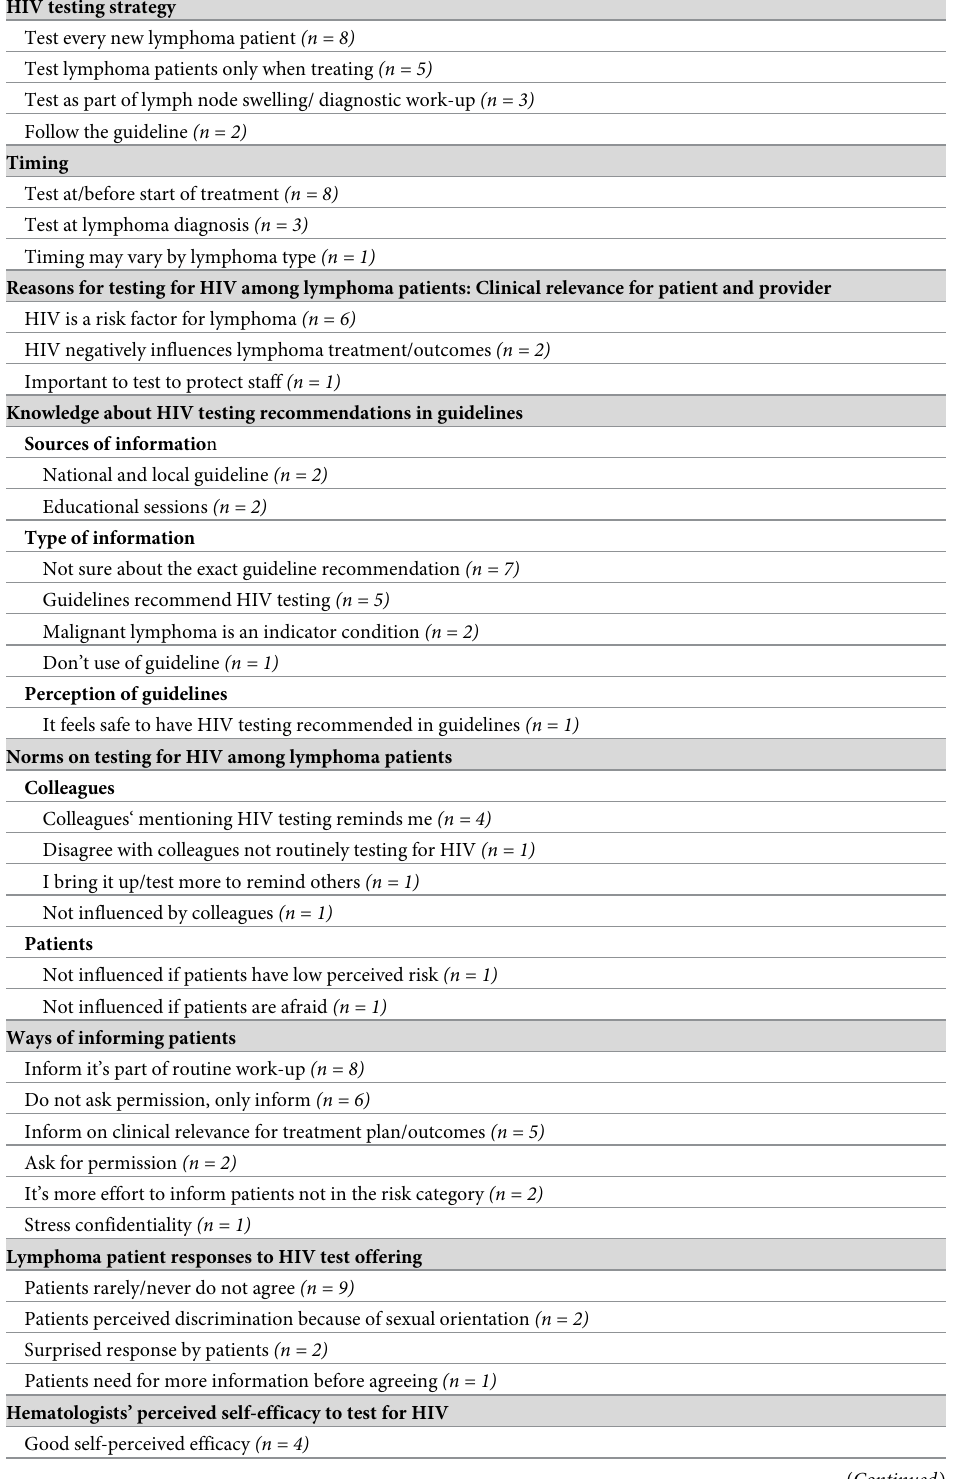
Table 2. Themes identified from semi-structured interviews with hematologists on their HIV testing behavior among lymphoma patients, and influencing